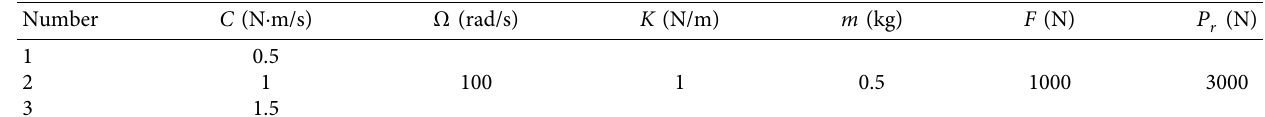
Table 2: Calculation parameters.